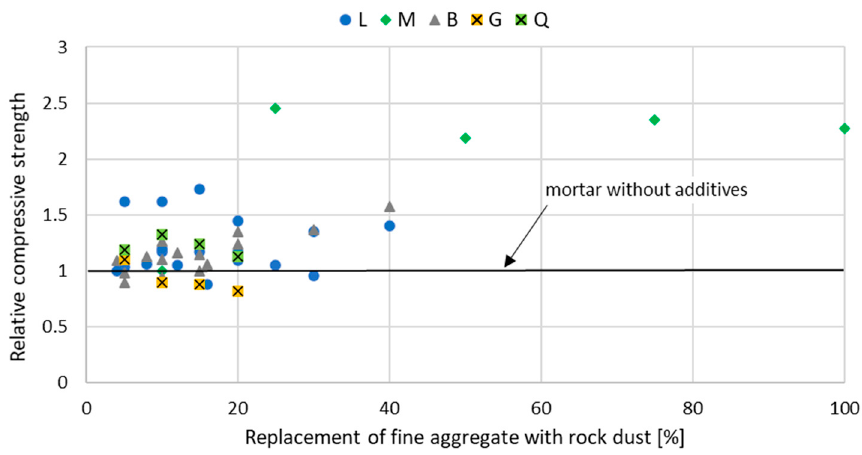
Figure 2. The effect of replacing fine aggregate with rock dust on the compressive strength of mortar after 7 days of curing: limestone dust (L) [46,55,95,97], marble dust (M) [67,76], basalt dust (B) [46,55,57,96], granite dust (G) [95], quartz dust (Q) [95].